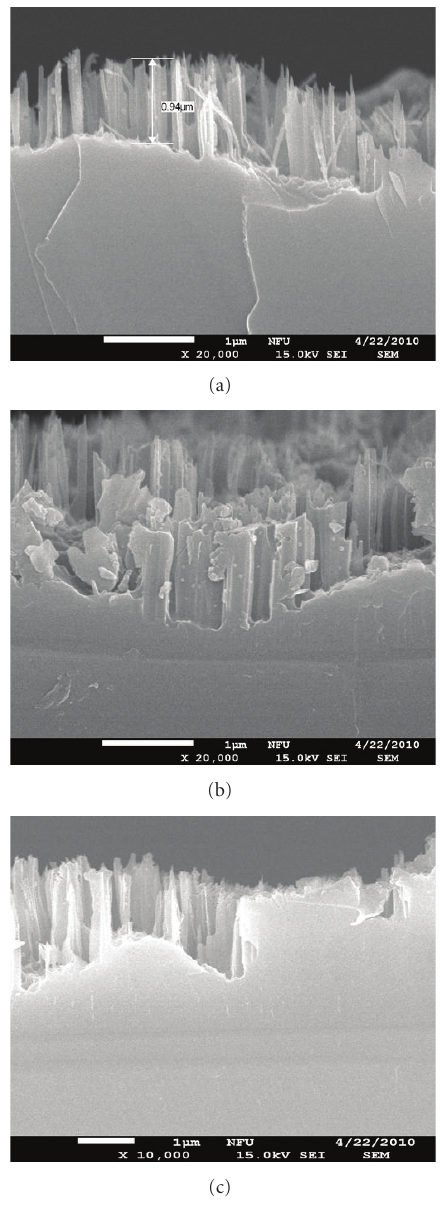
Figure 3: SEM images of various SNW/p-Si(100) structures. Etch- ing conditions were aqueous AgNO 3 /HF/H 2 O mixture chemical solution in a ratio of (a) 4:31 :165, (b) 4:38 :158, and (c) 4:41.5 :154.5 (volume) at 25 ◦ C for 10 min. The concentration of AgNO 3 was 1 molL − 1